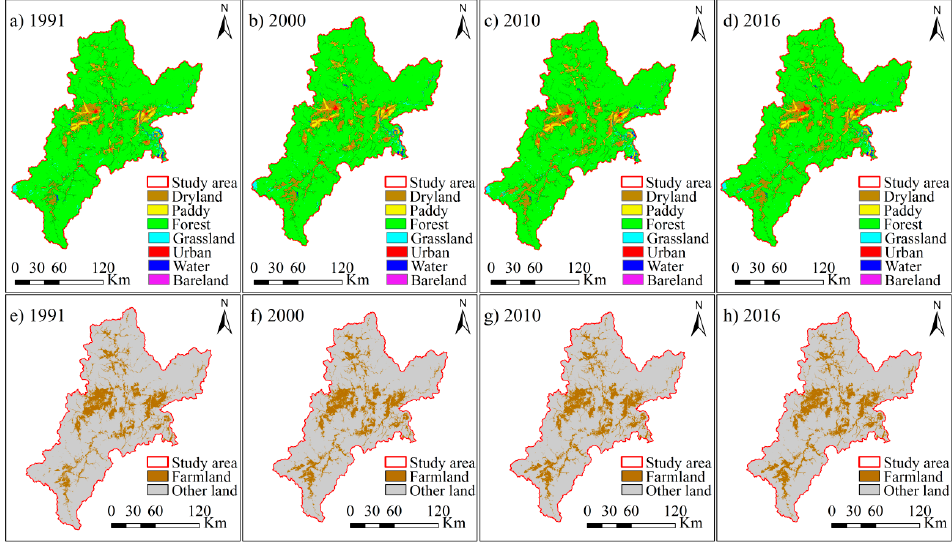
Figure 4. The results of land cover ( a – d ) and farmland classification ( e – h ) for different years.